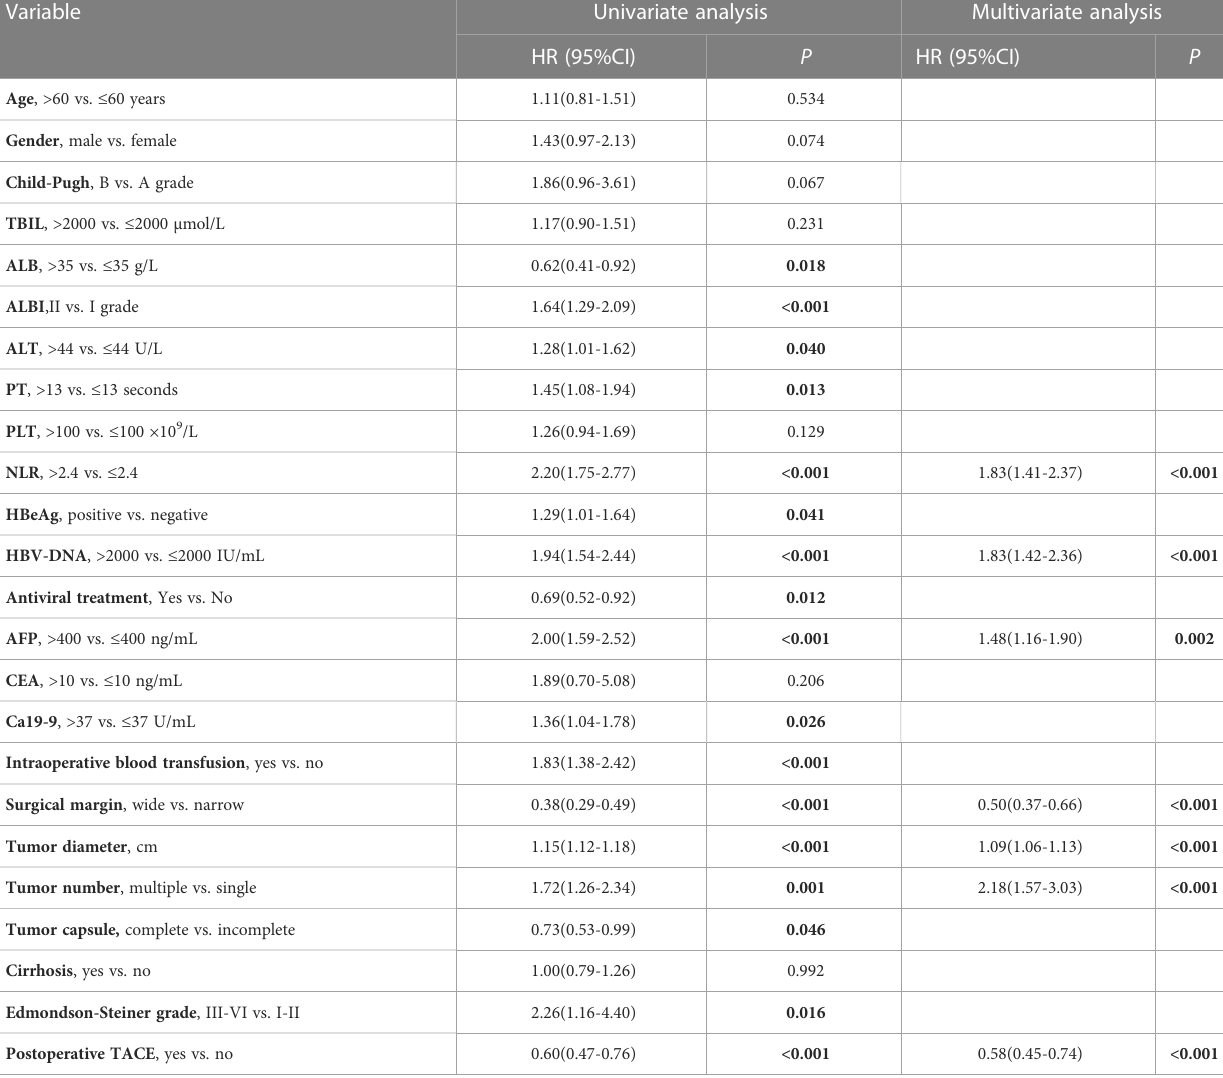
TABLE 3 Univariate and multivariate cox regression analysis of OS in the training